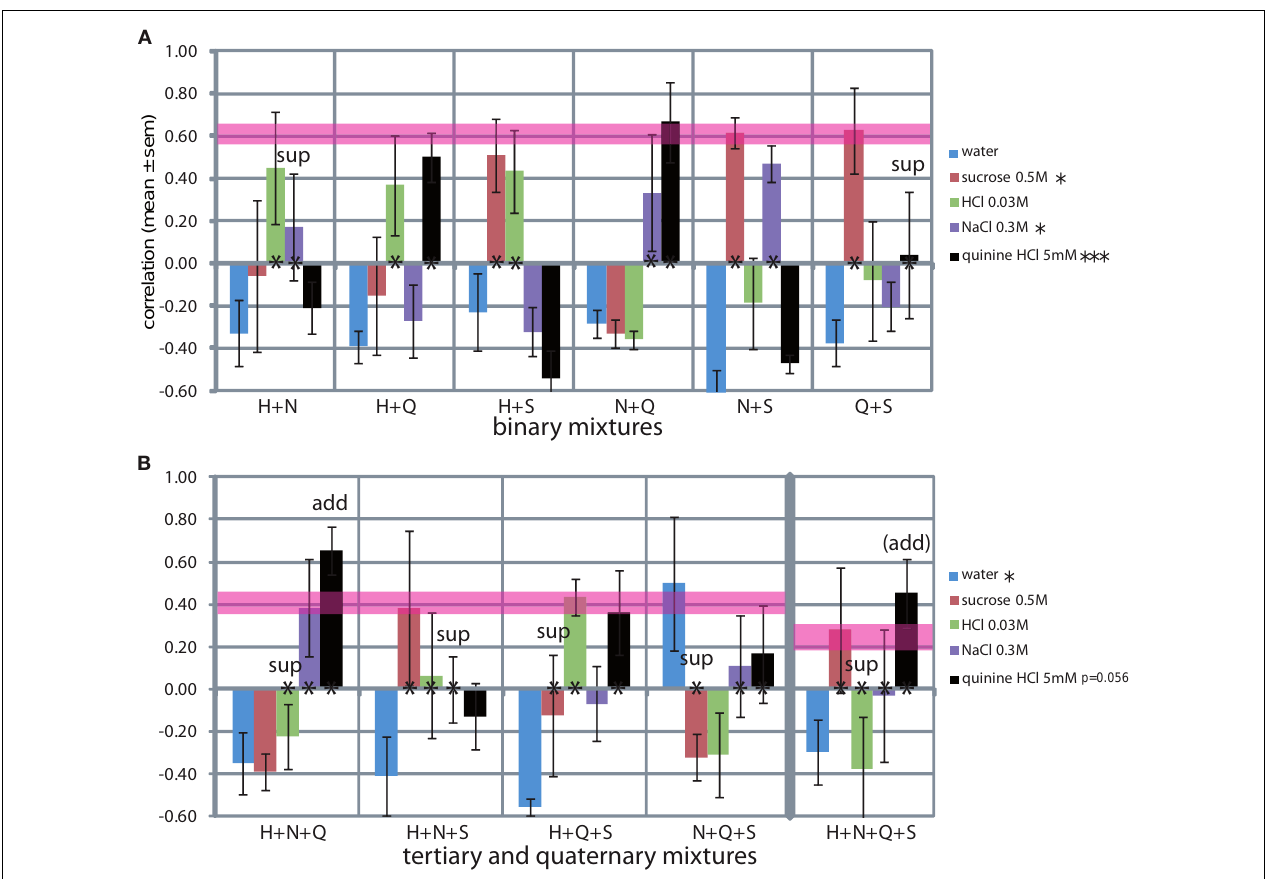
maximum similarities assuming an even distribution of responses across the “correct” spouts associated with the elements of the mixture (binary r = 0.61 ± 0.05, tertiary r = 0.41 ± 0.06, quaternary r = 0.25 ± 0.07). “sup”: suppression of the element, “add”: additivity of (domination by) the element. See Discussion for Monte Carlo